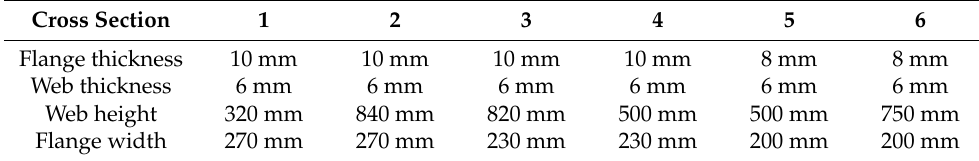
Table 1. Main girder cross-sectional